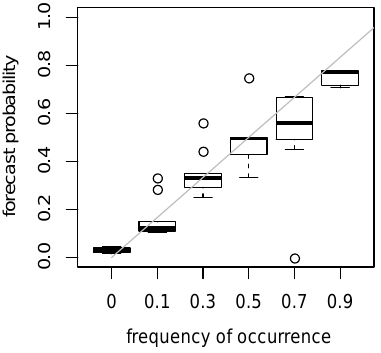
Figure 9. Average reliability of AFFS. Each boxplot summarizes the median reliability of the 36 key stations, considering all lead times.